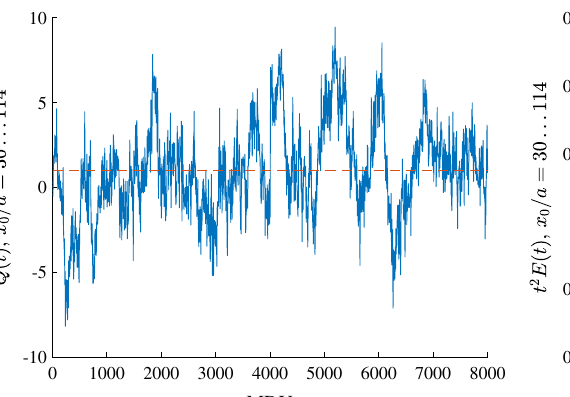
(blue) and plaquette (red), which differ by O ( a 2 ) effects. Due to open boundary conditions we average only over time slices x 0 / a = 30 ... 114, as indicated in the ordinate